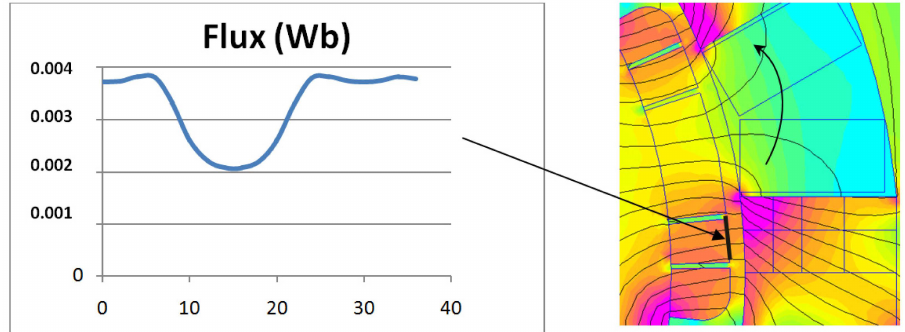
Figure 20. At no load, the rotor position is increased step by step (0 ˝ to 36 ˝ ). For each position, the flux on one magnet surface is plotted. The slots are opened, there are high permeance variations, and the flux in the magnet is affected by high fluctuations which induce eddy